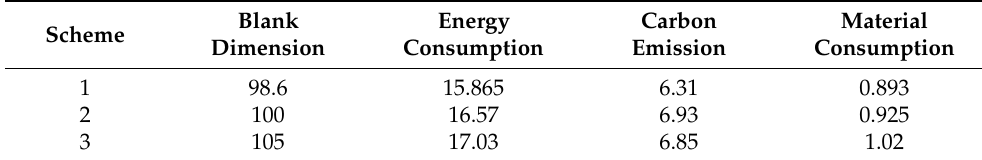
Table 8. Comparison of different blank dimensions and optimization objectives. Scheme